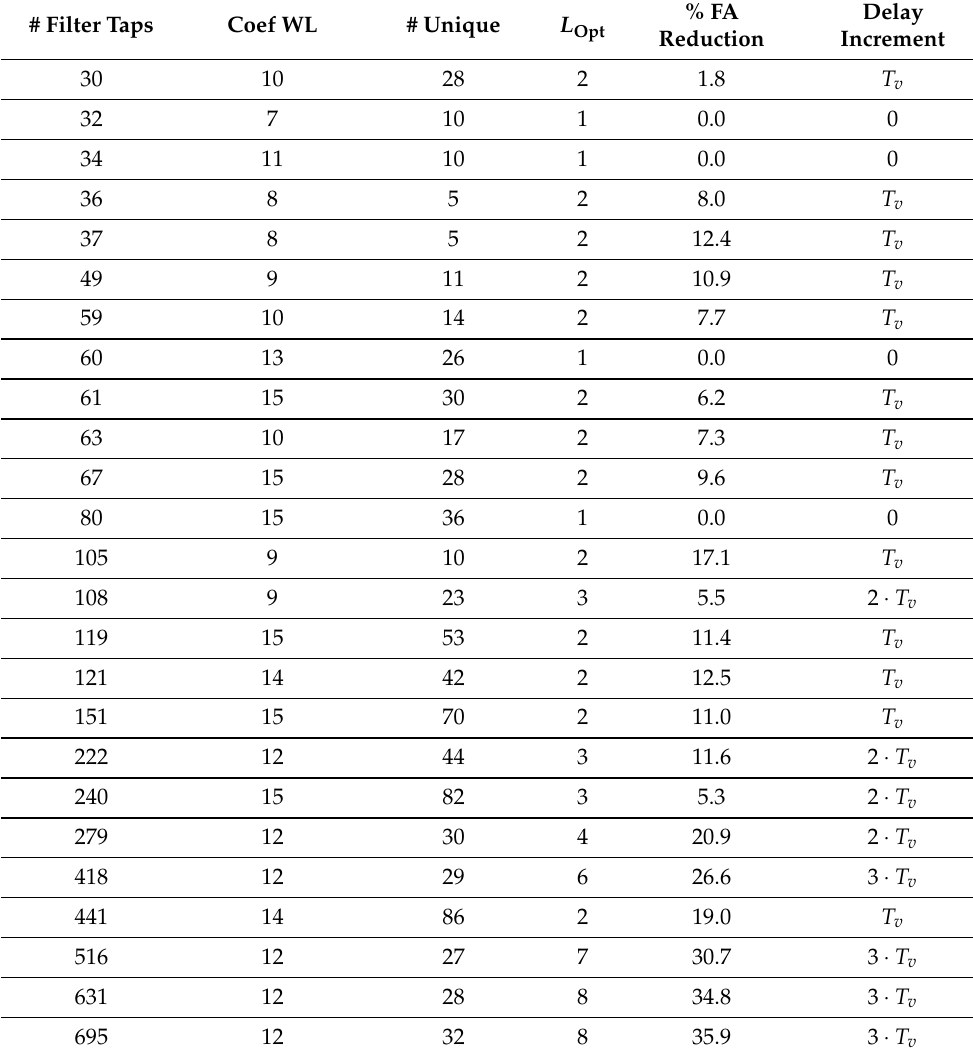
Table 3. Results for filters with different